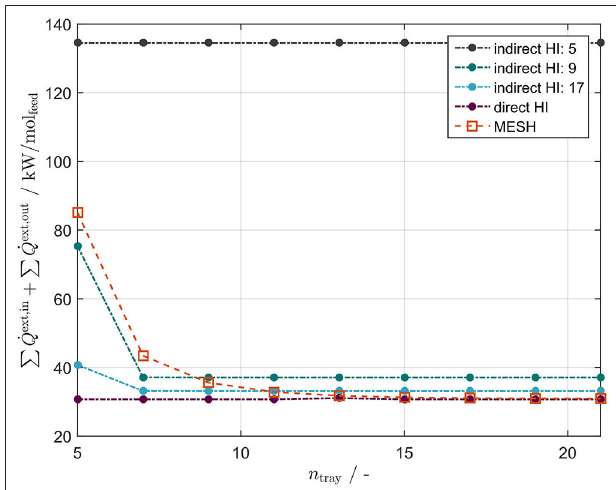
FIGURE 8 | Influence of number of separation stages on the total energy duty if additional heat transfer is considered. Illustrated are the results of the FluxMax formulation considering different temperature discretizations (5, 9, and 17 temperature levels) as well as of the classical and extended MESH formulations as a benchmark.